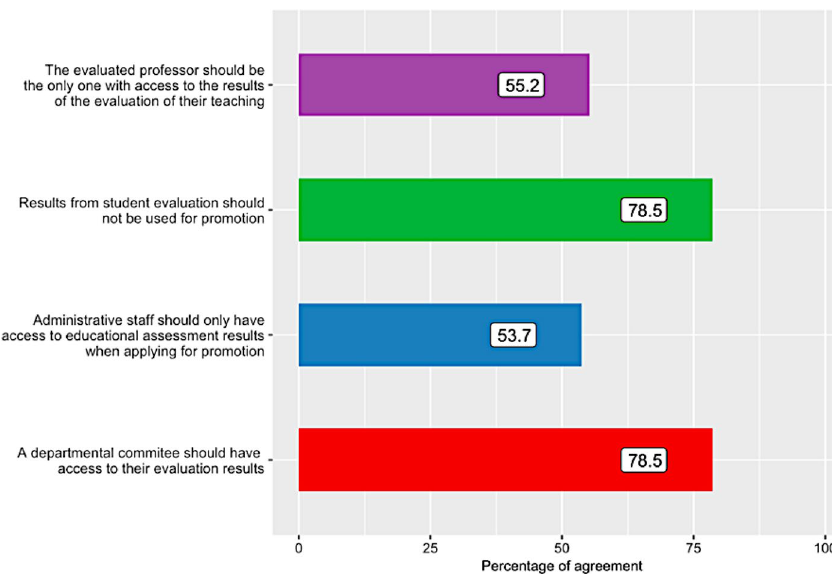
Fig. 4 Percentage of respond‑ ents who say they "tend to agree or totally agree" regarding access to and use of